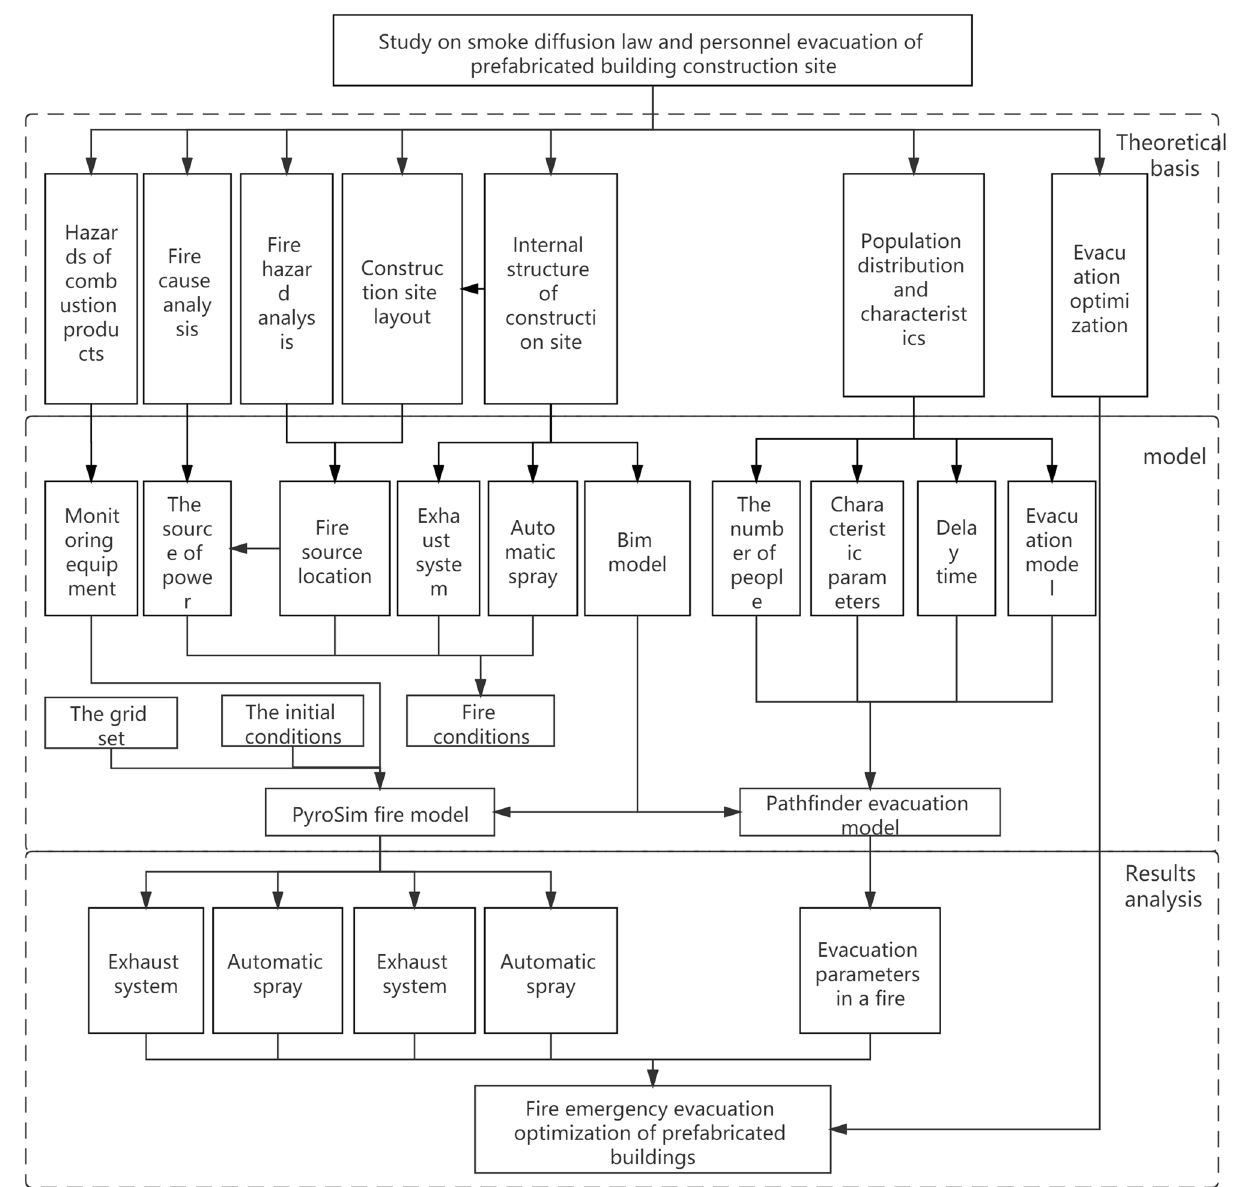
Figure 1. General framework for fire emergency evacuation from prefabricated building construction